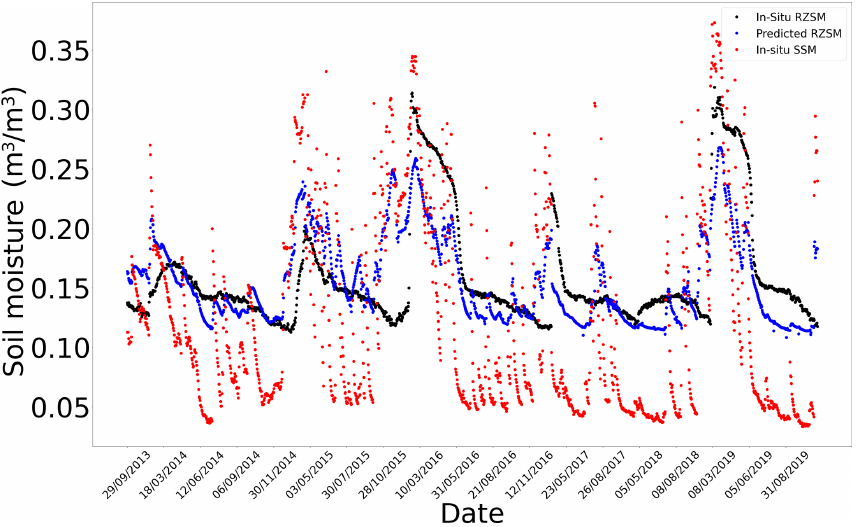
Figure E4. In situ SSM, in situ RZSM, and predicted RZSM series at station HarmsWay (SCAN) with model ANN_SSM_NDVI_EVAP-